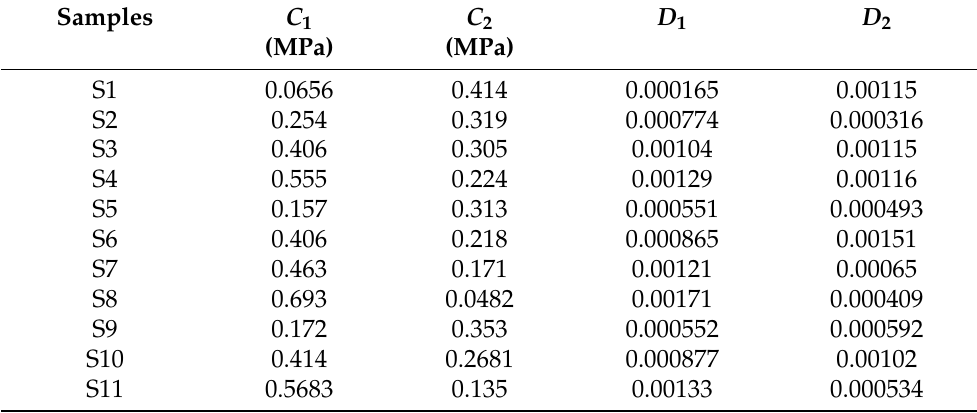
Table 3. Mooney–Rivlin parameters C 1 and C 2 obtained by fitting stress–strain curves in Figure 10 with Equation (16). Effective Mooney–Rivlin parameters D 1 and D 2 obtained by fitting the average orientation parameter curves in Figure 13 with Equation (17). See also Figure